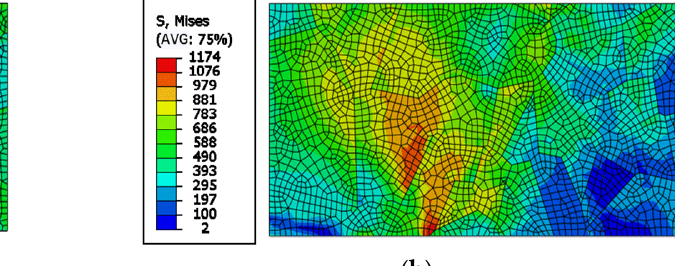
Figure 17. Master curve of fracture toughness.